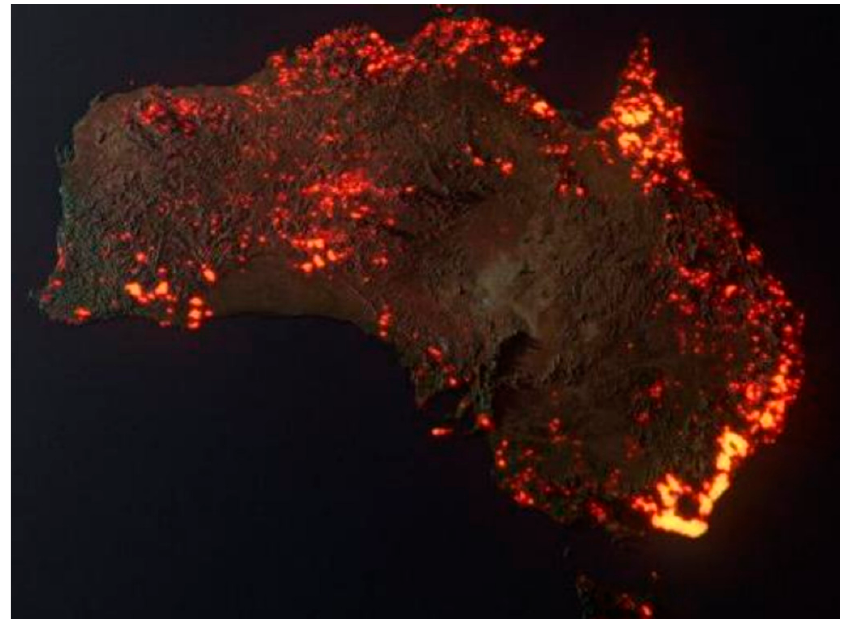
Figure 4. This visualization of fire hotspots in Australia may appear lifelike, but it is not a photograph and does not accurately reflect the size or number of fires burning at any one time. Australia is Burning/A 3D Visualization (2019) (available at https://anthonyhearsey.com/australia-is-burning-a-3d-visualisation, accessed on 24 August 2022) by Anthony Hearsey. Reproduction courtesy of the artist.